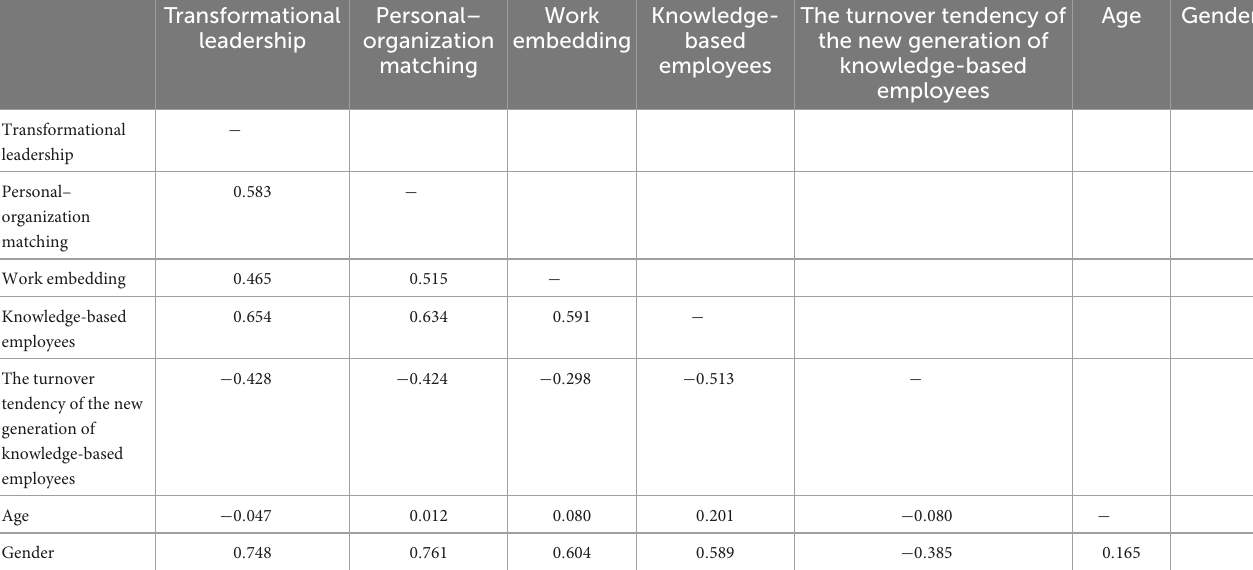
TABLE 3 Heterotrait-monotrait ratio result.